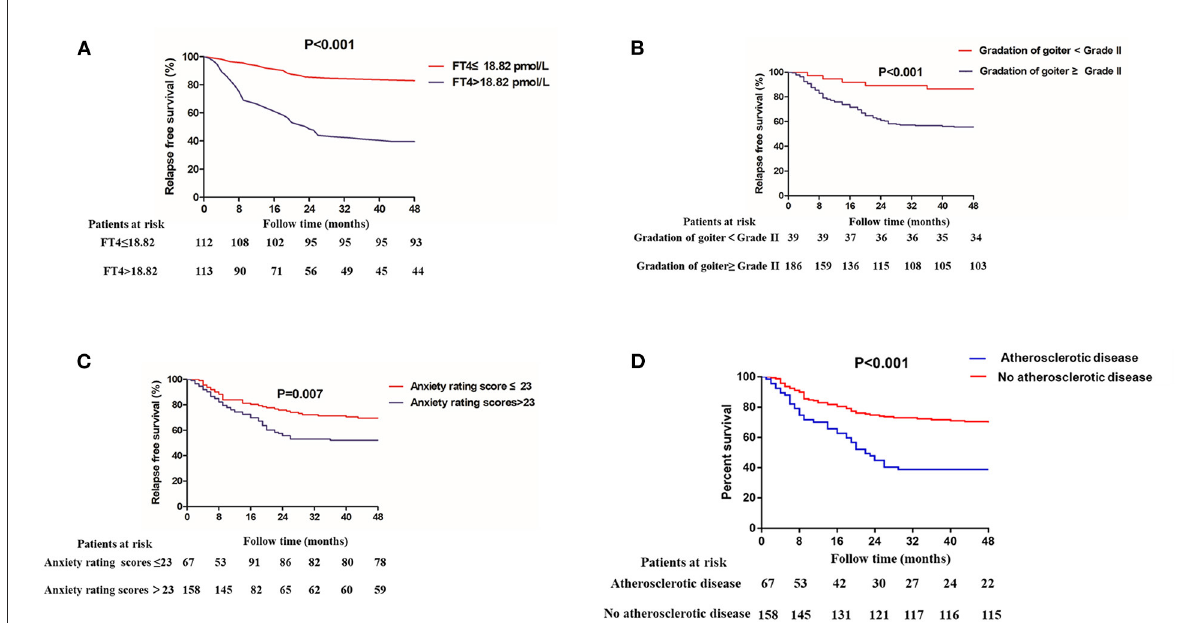
FIGURE2 Kaplan–Meier analyses for patients with GD who underwent antithyroid drug (ATD) treatment and relapse during ATD reduction. (A) The serum level of free thyroxine (FT4), (B) goiter gradation, (C) anxiety rating scores, and (D) Atherosclerotic